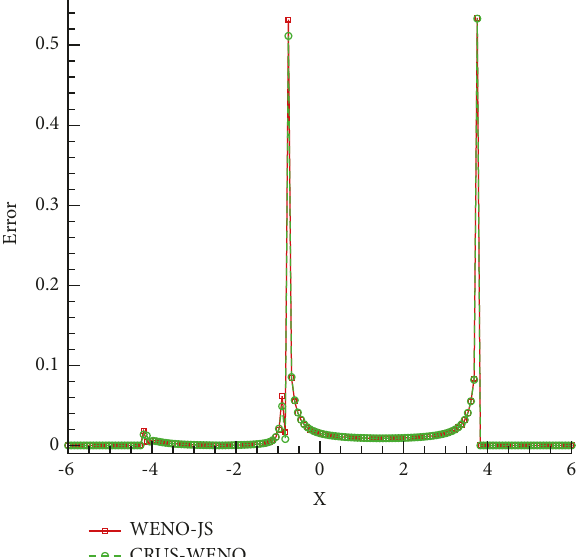
Figure 3: Example 4. Collision of two-box solution for PME. Errors of WENO-JS scheme and CRUS-WENO scheme with 160 grid points. T � 0.04. The reference solution is computed by WENO-JS scheme with 1600 grid